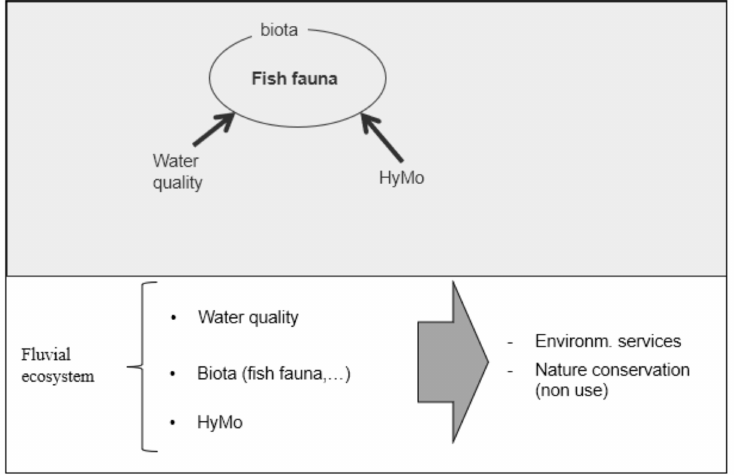
Figure 1. ( Top ): value tree adopted by the J ú car RBA in full agreement with the WFD (“HyMo”, Hydro-Morphological component). ( Bottom ): The corrected value tree for fluvial ecosystems where all three components participate in determining the overall ecosystem health (see